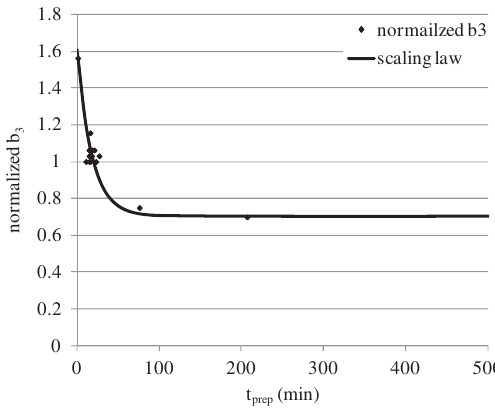
FIG. 11. Normalized b 3 decay amplitude and the scaling law against the preparation time.